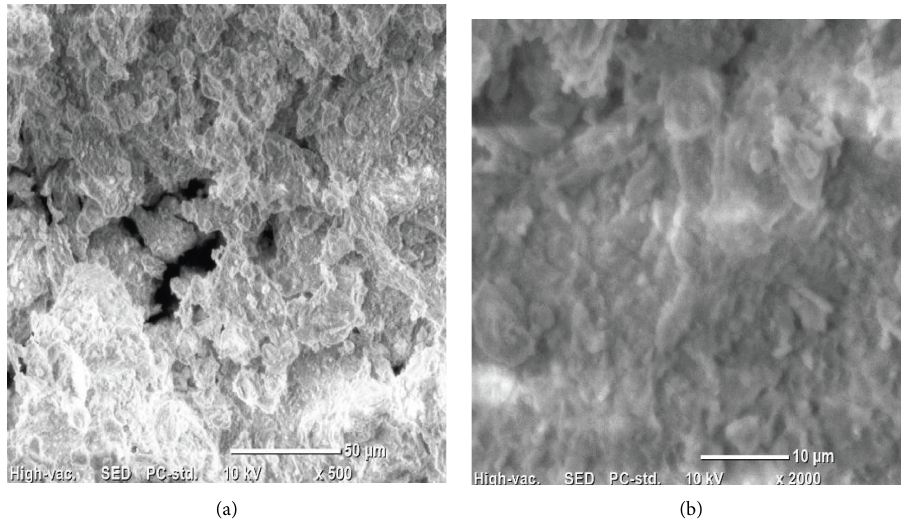
Figure 19: SEM images of the highly expansive soil at different sizes and magnification rates. (a) 50 µ m, × 500. (b) 10 µ m, ×